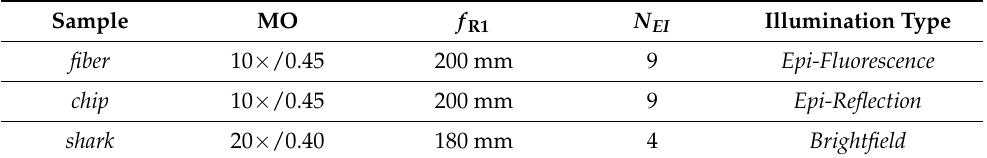
Table 1. Acquisition data for the different samples. First column: the microscope objective information is shown in the classical magnification/numerical aperture format. Second column: R1 lens focal length. Third column: number of EIs. Fourth column: illumination